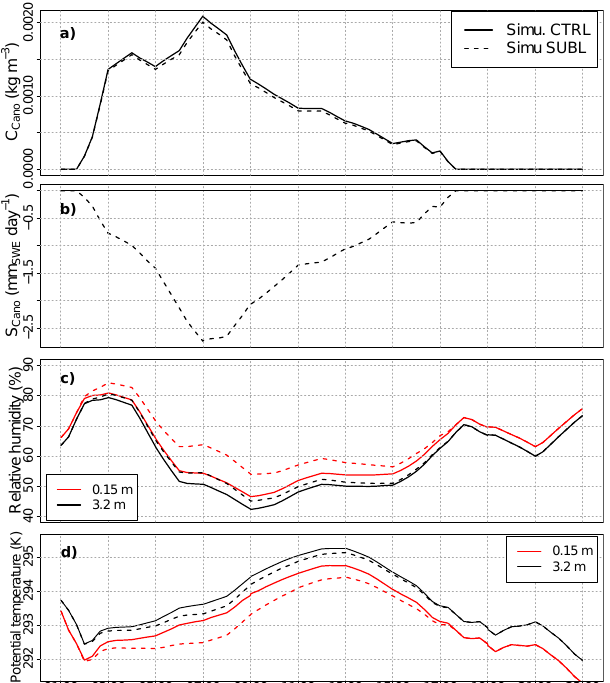
Fig. 11. Times series simulated at Col du Lac Blanc of (a) average concentration of blowing snow in Canopy; (b) vertically integrated sublimation rate in Canopy; (c) relative humidity with respect to ice at two levels and (d) potential temperature at two levels. Plain and dashed lines refers respectively to simulation CTRL and SUBL. The total thickness of Canopy is 3.05m at Col du Lac Blanc.